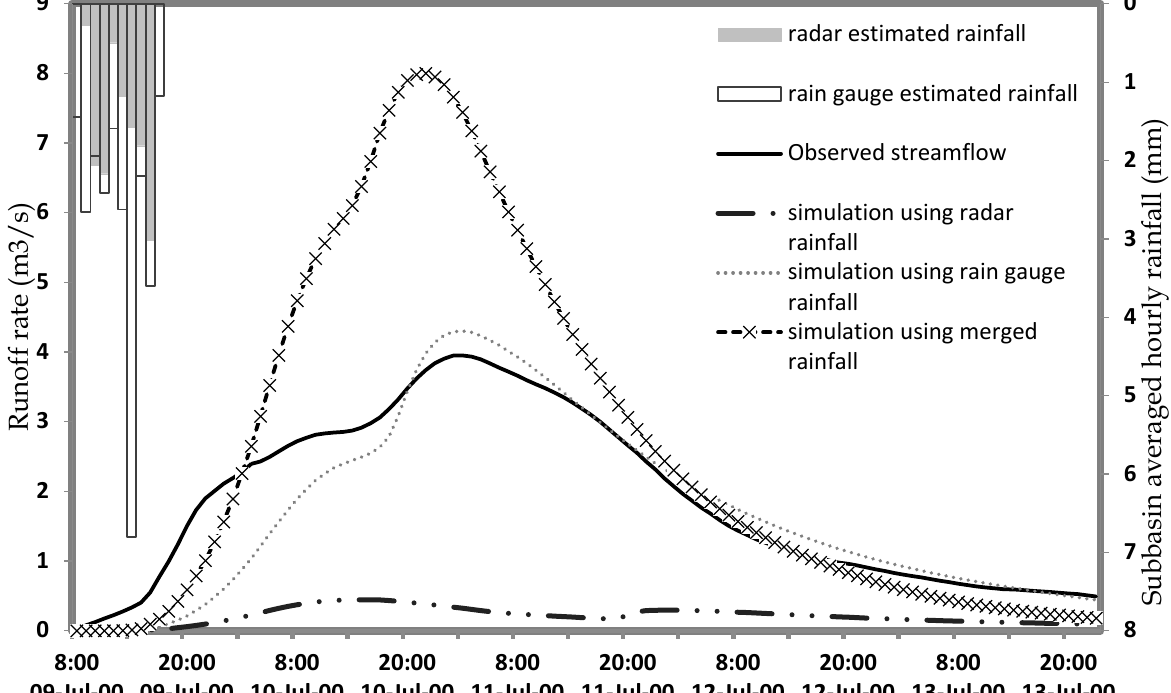
Figure 20. Comparison of estimated and observed hydrographs using different rainfall estimates for the 9 July 2000 event with Green and Ampt modeling option.